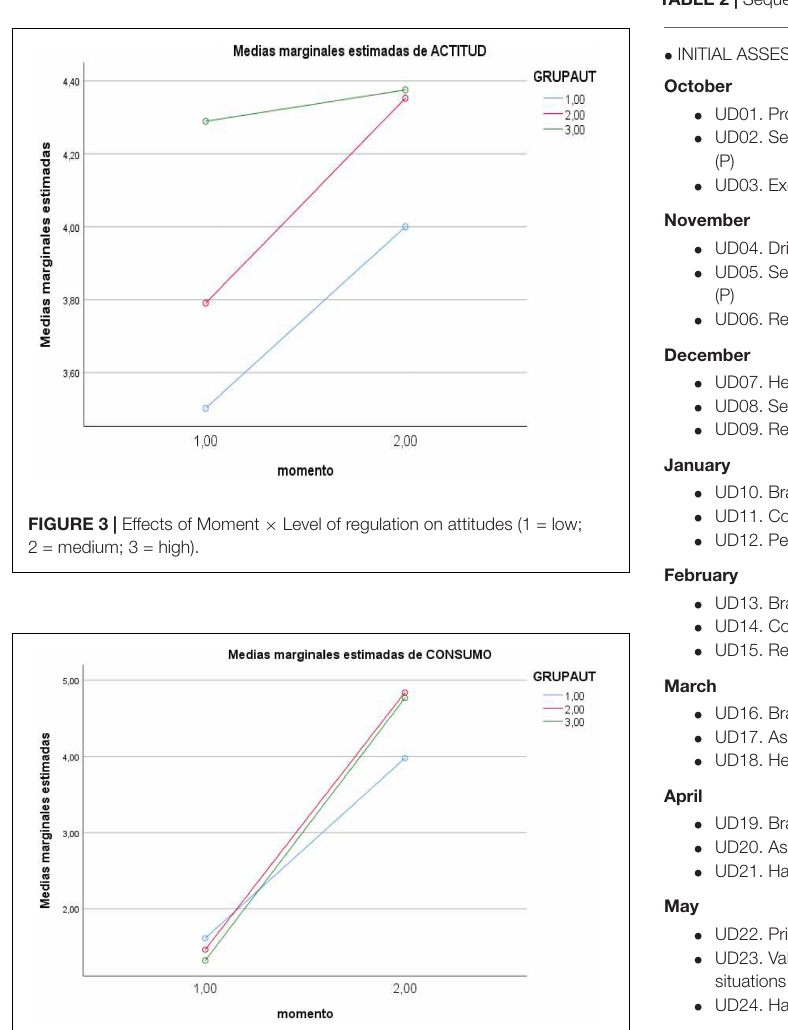
TABLE 2 | Sequence of the e-ALADO